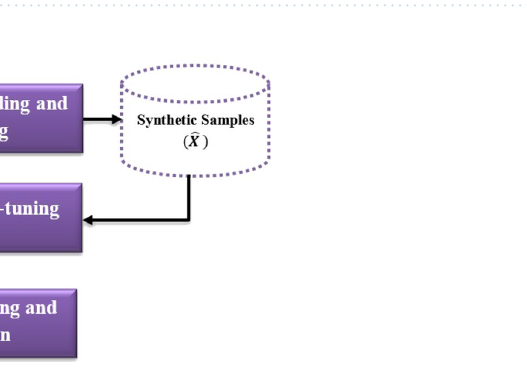
Figure 5. Different transfer learning models with their depth.